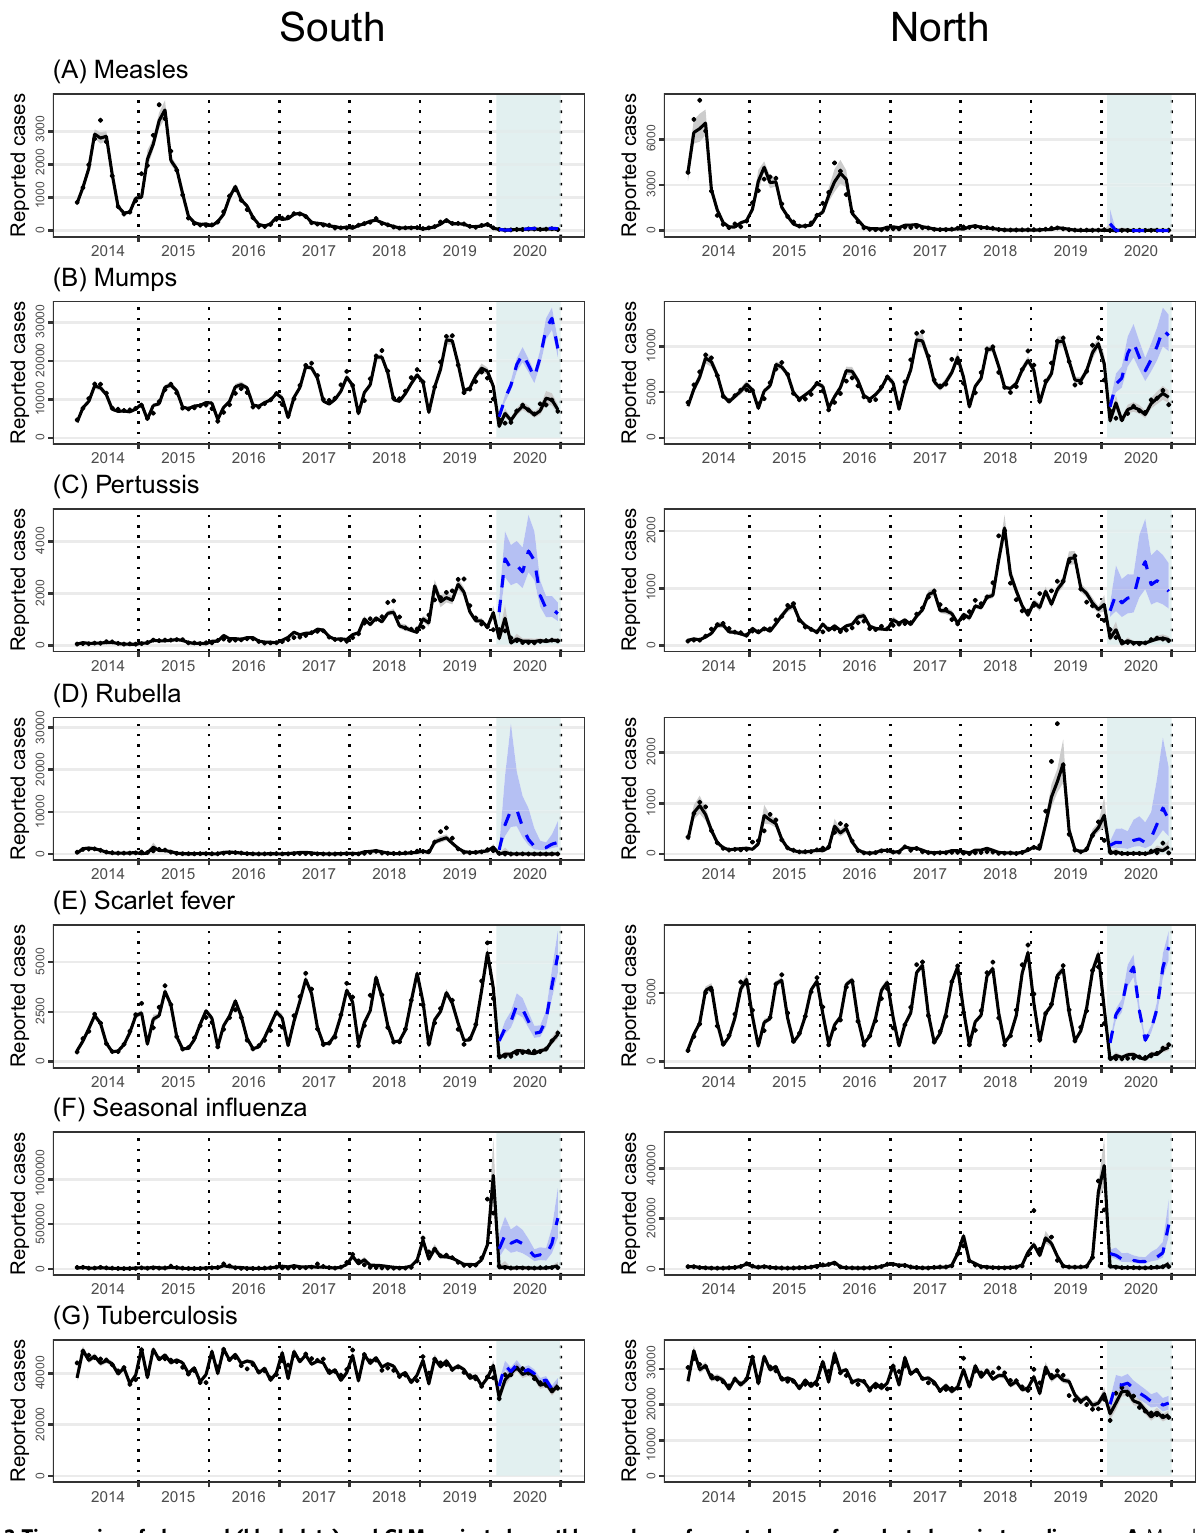
Fig. 2 Time series of observed (black dots) and GLM-projected monthly numbers of reported cases for selected respiratory diseases. A Measles, B mumps, C pertussis, D rubella, E scarlet fever, F seasonal in fl uenza, G tuberculosis. The model-projected trajectories are shown for both with (black solid) and without (blue dash, 2020 only) nonpharmaceutical interventions. Intervention phases II – IV (Feb – Dec) in 2020 are colored light blue. For the counterfactual trajectory without NPIs, monthly volumes of outpatient visits in 2020 were assumed the same as in 2019.